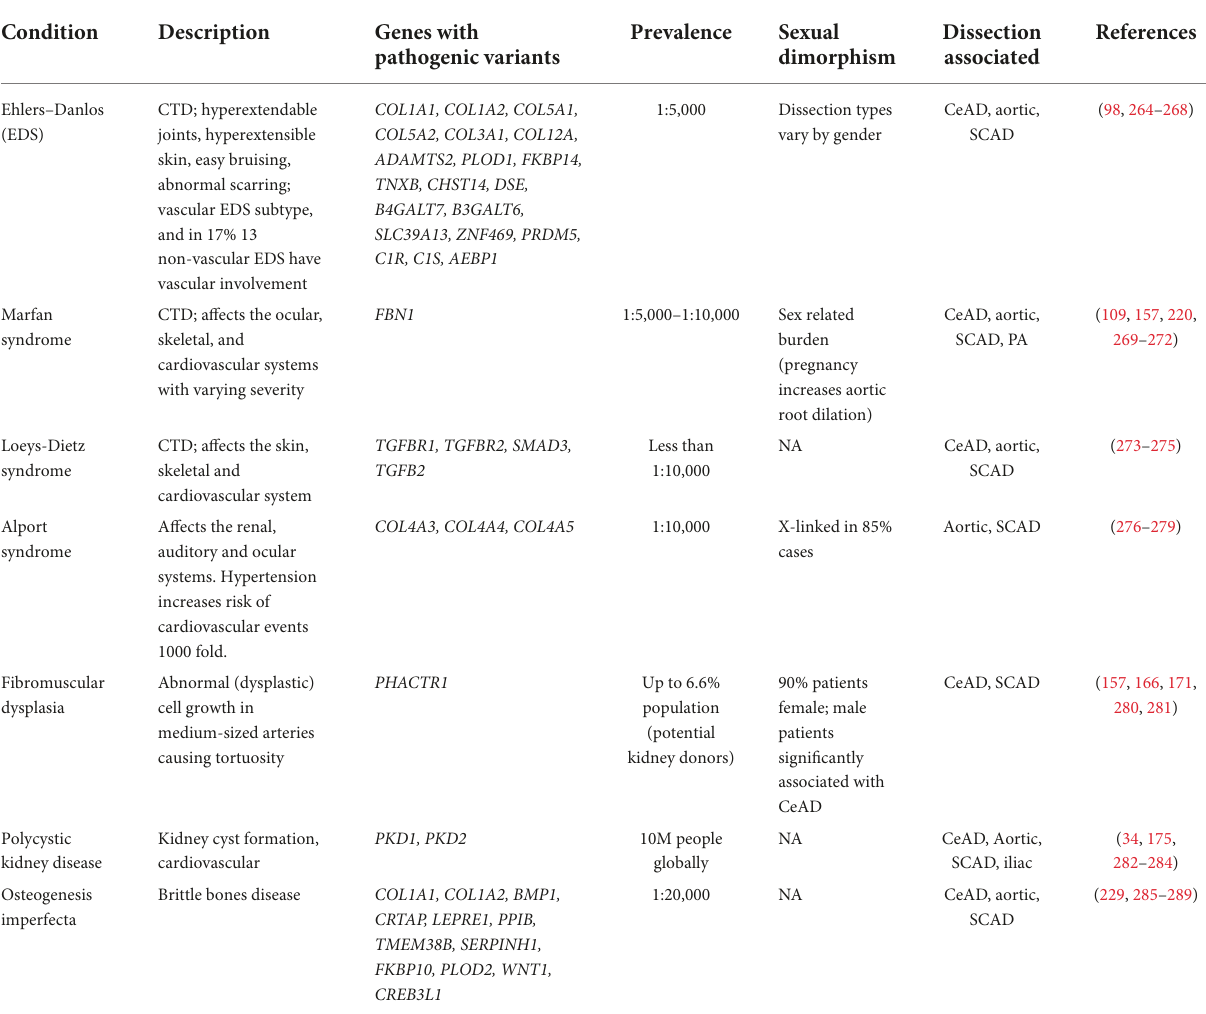
TABLE 1 Arterial dissection associated